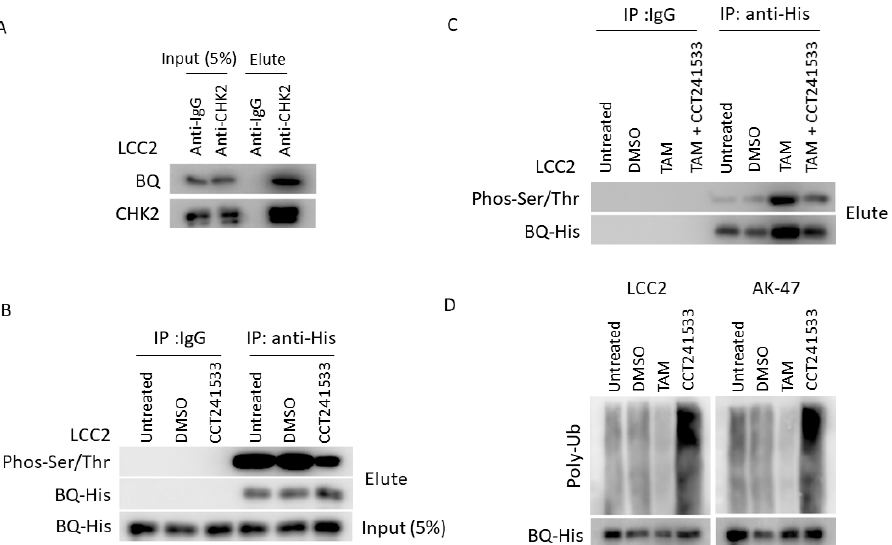
Figure 6. CHK2 could phosphorylate BQ to enhance its protein stability. ( A ) CHK2 could interact with BQ. LCC2 cells were lysed and immunoprecipitated with anti-CHK2. The immunoprecipitant was analysed by Western blot to detect the presence of endogenous BQ and CHK2. ( B ) The treatment of CCT241533 could reduce the degree of BQ phosphorylation. LCC2 cells were transfected with pcDNA3.1-His-BQ, and the cells were treated with 10 nM of CCT241533 for 48 h. The cells were immunoprecipitated with anti-His antibody. The immunoprecipitant was analysed with anti-His to confirm the presence of BQ in the immunoprecipitant and anti-phos-(Ser/Thr) antibody to determine the degree of phosphorylation on BQ protein. ( C ) The addition of CCT241533 could reduce the relative level of p-BQ in TAM-treated LCC2 cells. LCC2 cells were transfected with pcDNA3.1-His-BQ, and the cells were treated with 4 µM of TAM and 10 nM of CCT241533 for 48 h. The cells were immunoprecipitated with anti-His antibody. The immunoprecipitant was analysed with protein A-HRP and anti-phos-(Ser/Thr) antibody to determine the degree of phosphorylation on BQ protein. ( D ) The effect of TAM and CCT241533 on poly-ubiquitination of BQ. LCC2 cells were transfected with pcDNA3.1-His-BQ, and the cells were treated with 5 µM of MG132 together with 4 µM of TAM or 10 nM of CCT241533 for 24 h. The cells were immunoprecipitated with anti-His antibody. The immunoprecipitant was analysed with anti-His to confirm the presence of BQ in the immunoprecipitant and anti-Ub antibody to determine the degree of poly-ubiquitination on BQ protein.